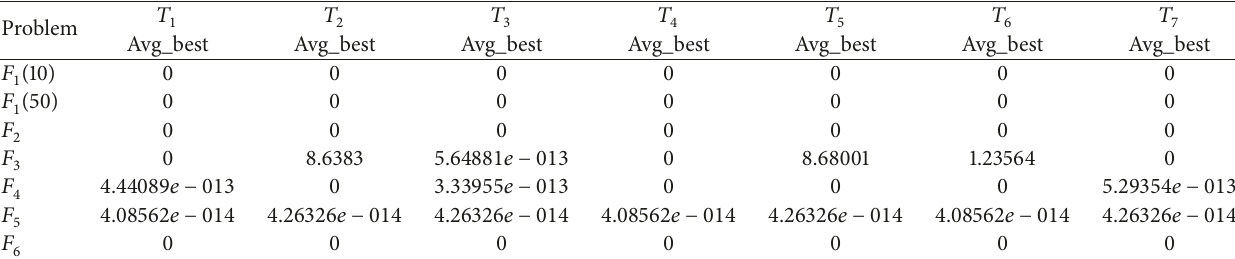
Table 4: Average best error values achieved for problems 𝐹 1 – 𝐹 6 by PLBA.